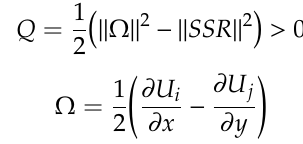
Figure 14. ( a ) Velocity vector map for f = 2 Hz and x o = 40 mm, ( b ) velocity vector map for f = 10 Hz Figure 14. (a) Velocity vector map for 𝑓 = 2 Hz and 𝑥 (cid:3042) = 40 mm, (b) velocity vector map for 𝑓 = 10 Hz and x o = 40 mm, ( c ) modified Q-criterion contour for f = 2 Hz and x o = 40 mm, ( d ) modified Q-criterion and 𝑥 (cid:3042) = 40 mm, (c) modified Q-criterion contour for 𝑓 = 2 Hz and 𝑥 (cid:3042) = 40 mm, (d) modified Q- contour for f = 10 Hz and x o = 40 mm (di ff erent phases of the oscillation cycle are shown in top corner criterion contour for 𝑓 = 10 Hz and 𝑥 (cid:3042) = 40 mm (different phases of oscillation cycle are shown in top corner of each plot). of each